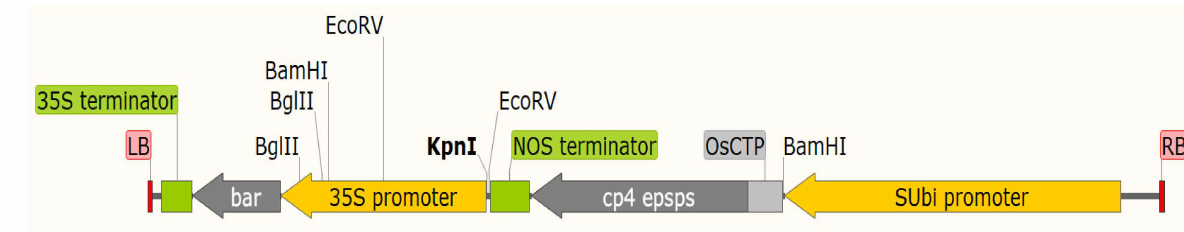
Figure 1. Diagram of T-DNA for expressing cp4 epsps and bar genes. LB, the left border of T- DNA. 35S promoter, CaMV35S promoter. bar , glufosinate-tolerant gene. 35S terminator, CaMV35S terminator. SUbi promoter, sorghum bicolor polyubiquitin promoter. OsCTP, Rice EPSPS CTP. cp4 epsps , glyphosate-tolerant gene. NOS terminator, nopaline synthase terminator. RB, the right border of